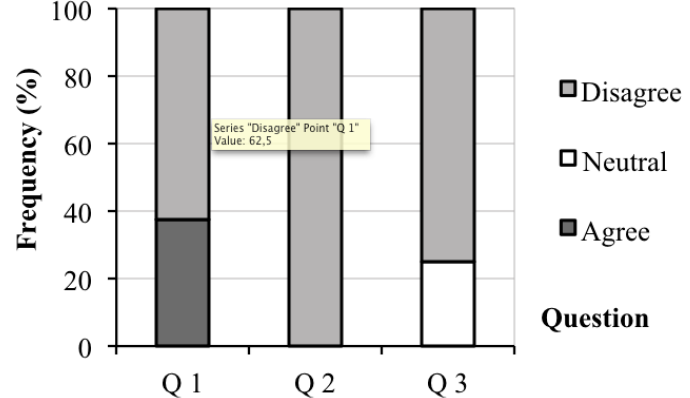
Fig. 6. Interviewees’ responses to the first three questions of the structured interview presented on a three-point Likert